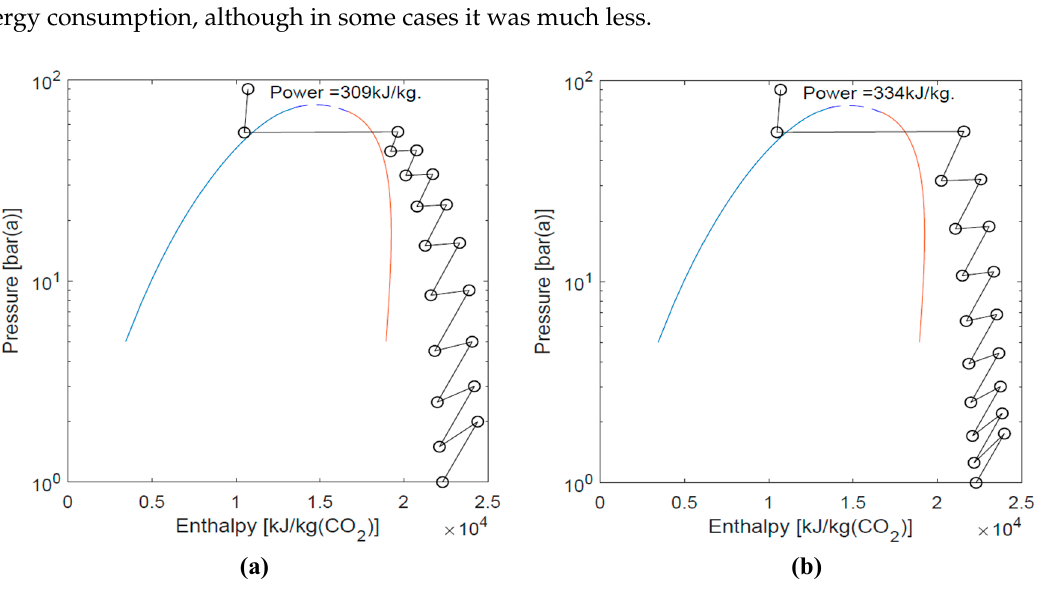
Figure 3. Energy consumption for a 10 stage CO 2 compressor, post-combustion capture case, P n = 90 bar(a) and To = 288 K with ( a ) constant Pr and ( b ) optimized Pr